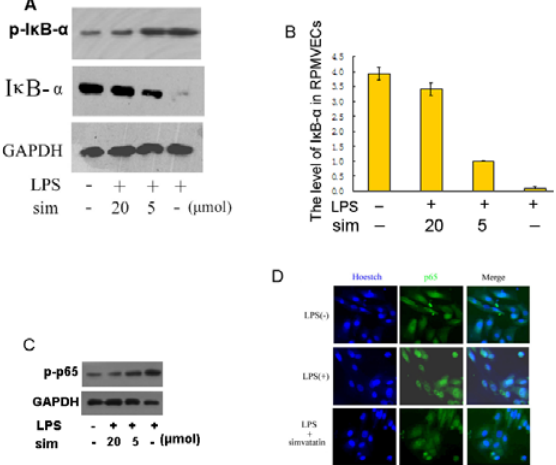
Figure 5. Simvastatin suppresses the LPS-induced inflammatory by inhibiting NF- k B transcriptional activity. A and B: Western blot showed that the simvastatin increase the level of I k B- a in RPMVECs exposed to LPS; C: Western blot showed that the simvastatin decrease the phosphorylation level of P65; D: the RPMVECs treated by LPS with the accumulation of p65 in nucleus by immunofluorescence staining, while not in cells co- incubated with simvastatin and